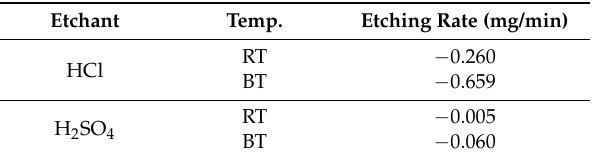
Table 5. The etching rates of CP Ti for different etchant solutions at RT or BT. Etchant